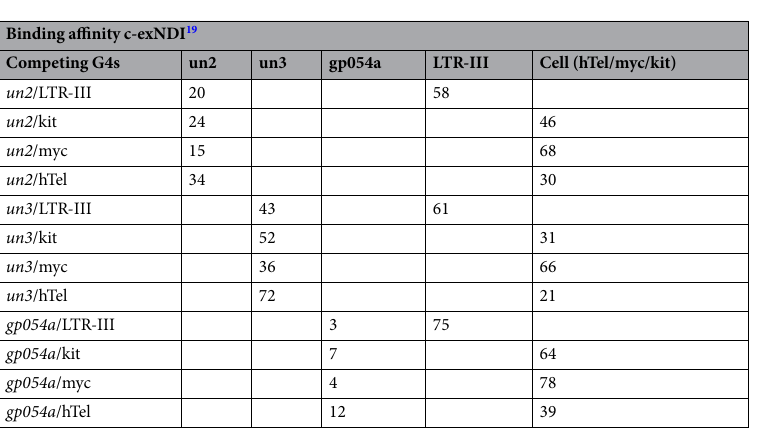
Figure 2. Taq polymerase stop assay on HSV-1 G4 folding sequences in the presence of c-exNDI. ( a ) un2 , un3 and gp054a were analyzed in the absence (lanes 1) or presence of 10 mM K + (lanes 2–5). c-exNDI was used at concentrations of 37.5, 75 and 100 nM (lanes 3–5). Elongation was performed at 60 °C. A non-G4 folding sequence was used as negative control (no G4 cnt). G4-related stops are indicated by vertical bars. FL stands for “full-length” amplified template. P indicates the primer lane. ( b ) Quantification of c-exNDI-induced stop sites observed in ( a ).